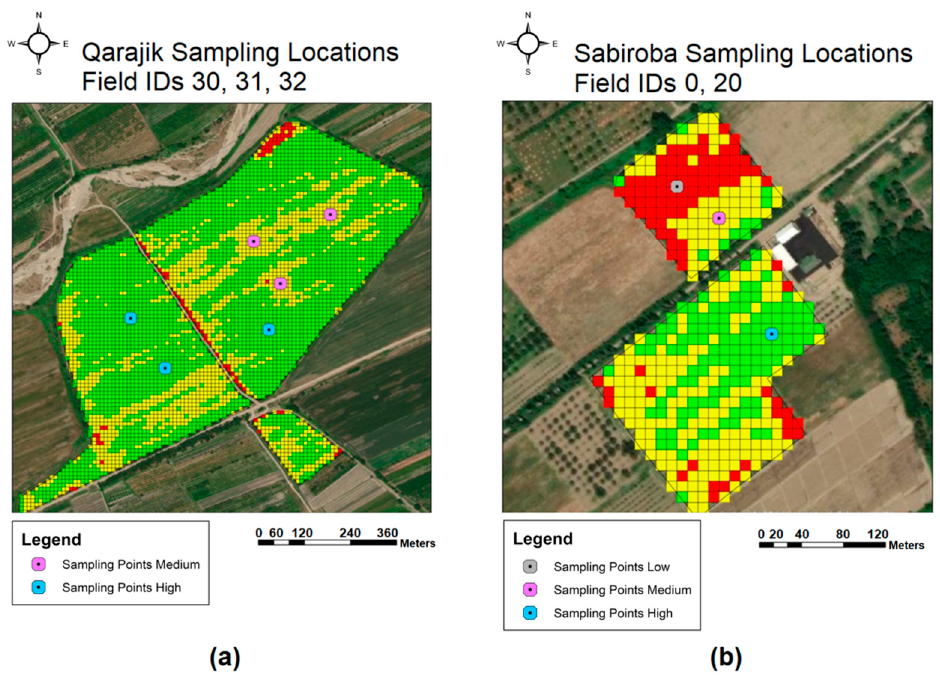
Figure 4. Two targeted sampling maps and the sampling location indicated by point vectors. The sampling locations took place in the ( a ) Qaracik Zeyid and ( b ) Sabiroba villages of Khachmaz, re- spectively.